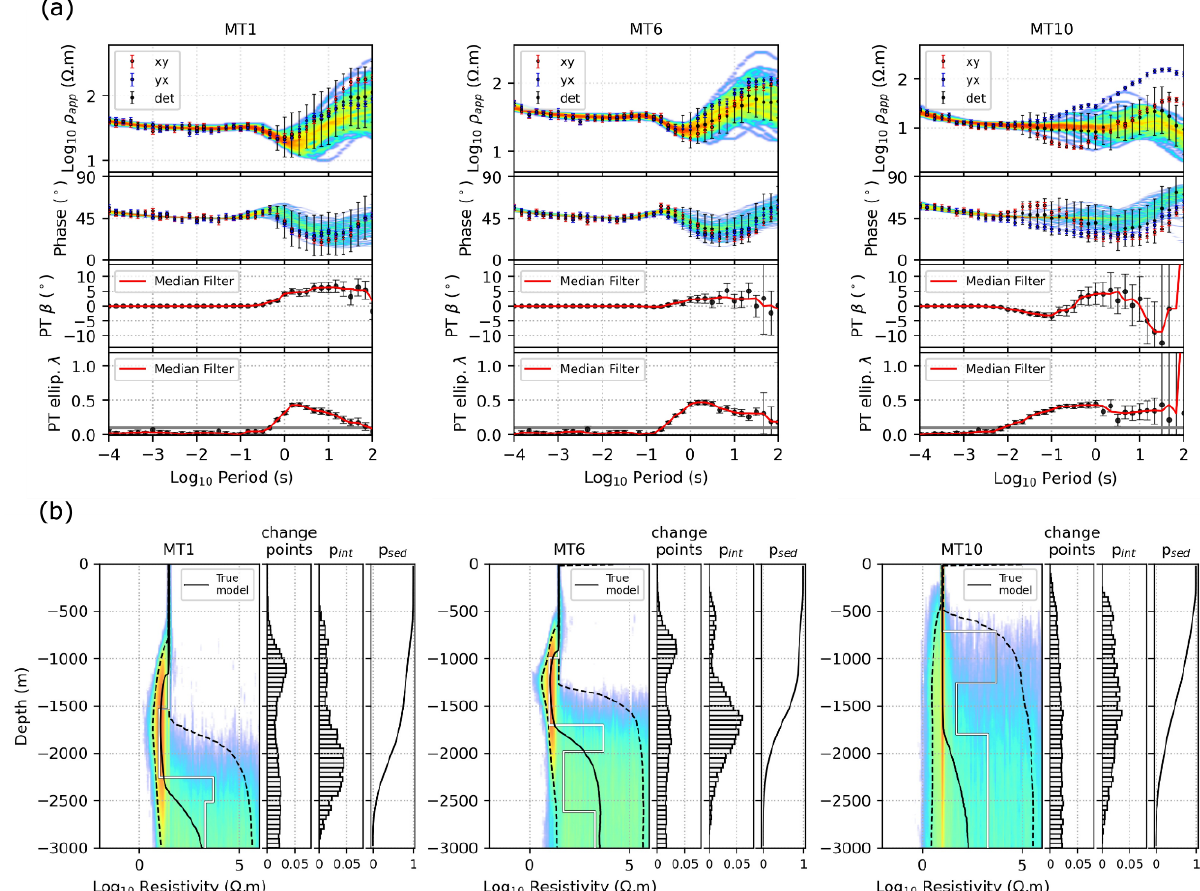
Figure 4. Example of posterior (a) response and (b) resistivity distributions for three MT sites MT1 (left), MT6 (middle) and MT10 (right), located along the profile as shown in Fig. 2. In (a) the phase tensor skewness β and ellipticity λ are shown. In (b) the change points (interface probability distribution), the cover–basement interface probability distribution p int and the sedimentary cover probability distribution p sed are shown. Sites MT1 and MT6 are located in the basin, and site MT10 is located in the area most affected by 2D and 3D effects (see Fig. 2c for location). High probabilities in the model posterior distribution are represented by warm colours, and low probabilities are represented with cold colours. The dashed lines represent the 5th and the 95th percentiles of the model posterior distribution, and the black line represents the median of the model posterior distribution. The white line is the true 1D model extracted beneath the MT